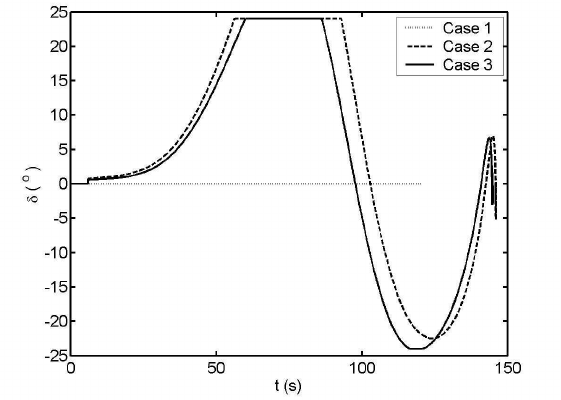
Fig. 3. Lateral accelerations for diffirent cases. The canard deflection angle profiles in different cases are plotted in Figure 4. Results shown that although the Table 1. Simulation cases. needed lateral acceleration is not high ( ＜ 0.5 g ) during flight at high altitude (above 15 km ), the available lateral acceleration of the rocket is also not enough. The main reason is that the density of air is very low at high altitude and ability to maneuver the rocket is limited.